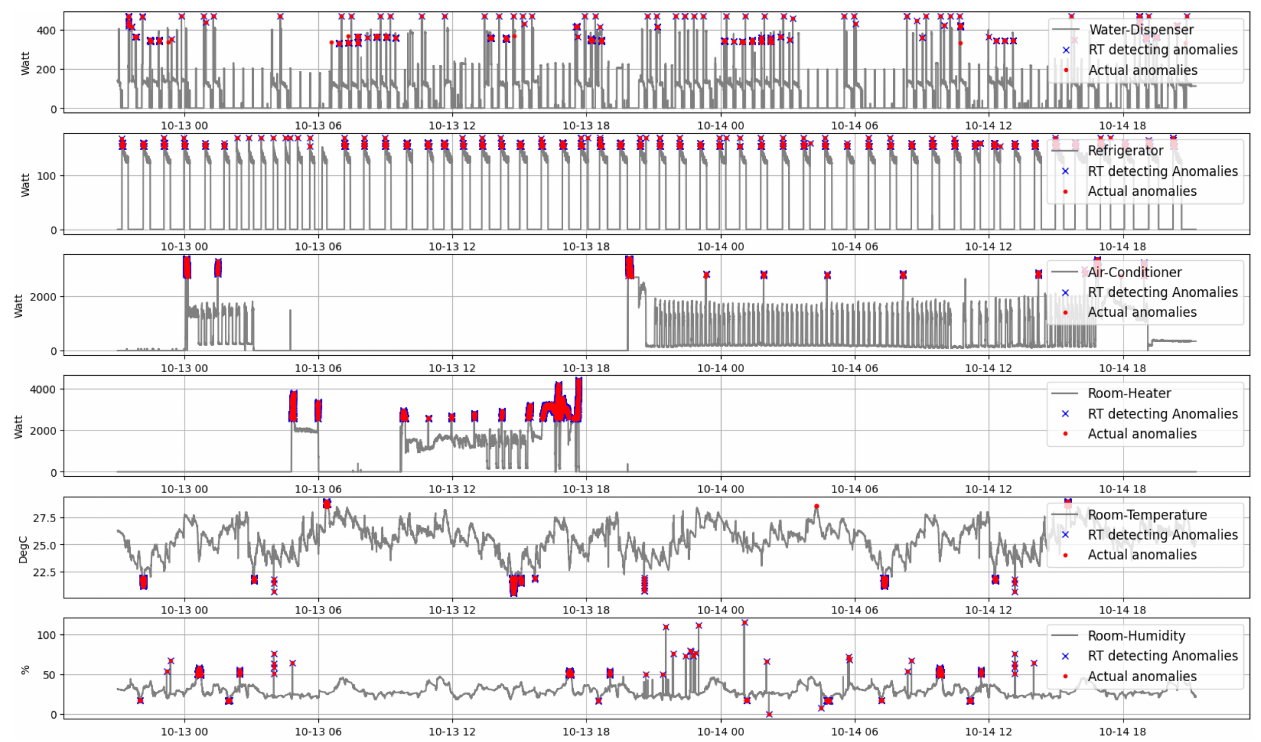
Figure 17. Anomalies found in the heterogeneous data of a house during testing phase.